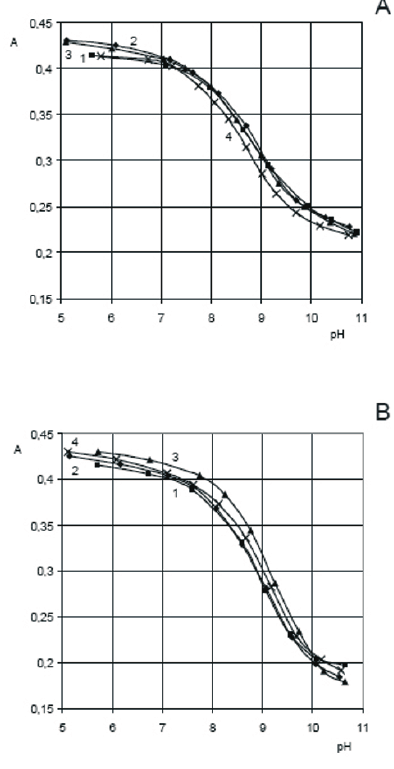
Figure 4. Absorption spectra of chelerythrine (c 2 – 5.16; 3 – 7.07; 4 – 8.03; 5 – 9.05; 6 – 10.03 Table 1. Values of molar absorptivity coefficients ε and the uncharged QOH (pseudo-base, 6-hydroxy-dihydroderivative, ε the A-pH curves by a SQUAD-G program. (c